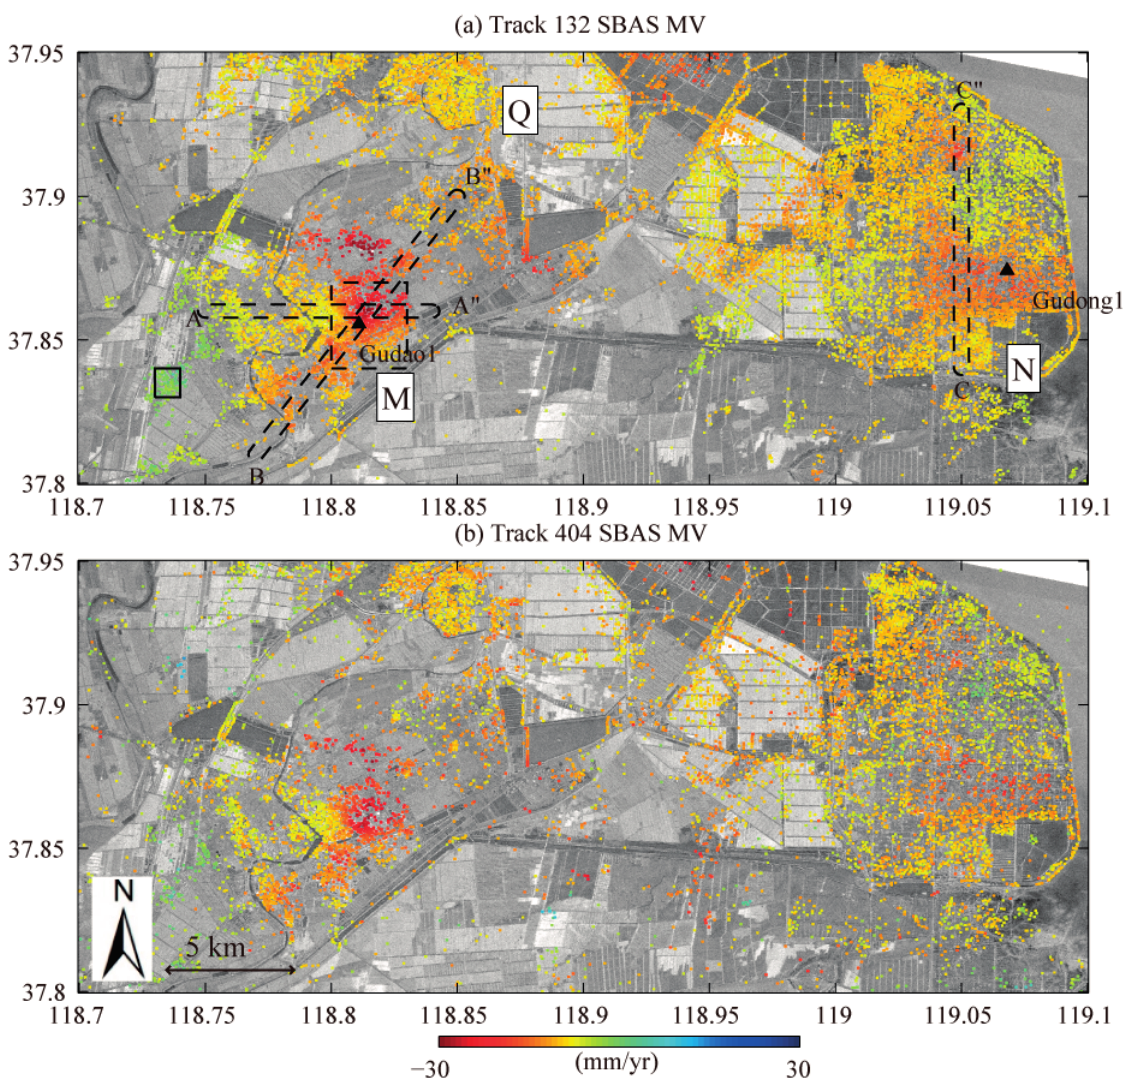
Figure 5. ( a ) Track 132: Mean displacement rates from SBAS analysis. ( b ) Track 404: Displacement rates from SBAS. Positions of three 500 meter wide swaths A-A", B-B" and C-C" are marked in (a). The reference area (small) and model area (large) are shown by rectangles in (a). Background is mean amplitude of SAR images. Area M, N, and Q are the locations of Gudao Town (oilfield), Gudong Town and Xianhe Town,